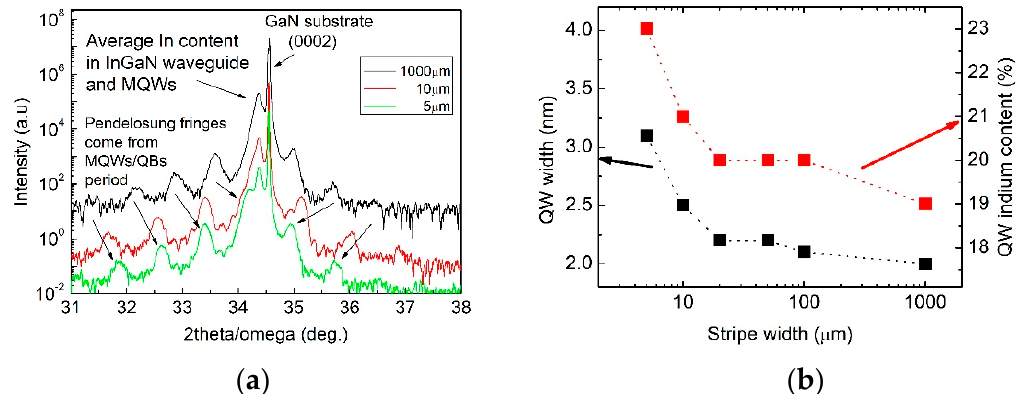
Figure 6. HR-XRD measurements of the InGaN/GaN MQW structure on substrate with 4 μ m high stripes; ( a ) 2theta-omega scans collected at 1000 µm wide reference area, at 10 µm, and 5 µm stripe regions (other regions not shown for picture clarity); ( b ) quantum well (QW) width and QW indium composition for different stripe widths obtained by fitting respective HR-XRD scans. The X-ray beam covers the whole width of each stripe.